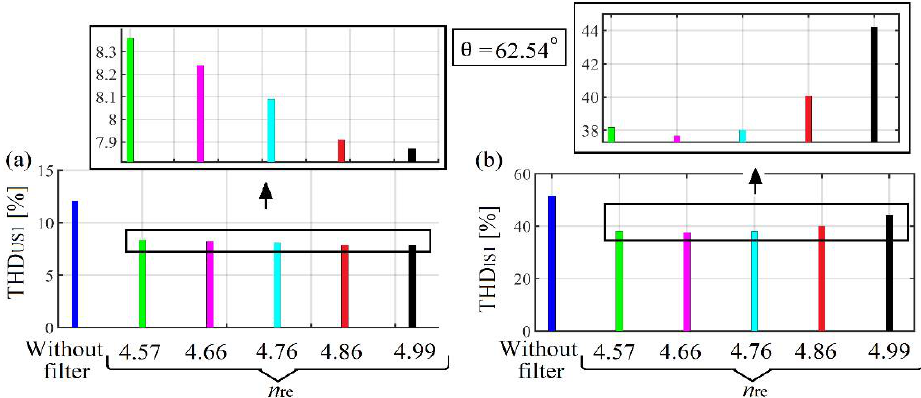
Figure 56. THD of the grid voltage ( a ) and current ( b ) for different resonance frequencies.